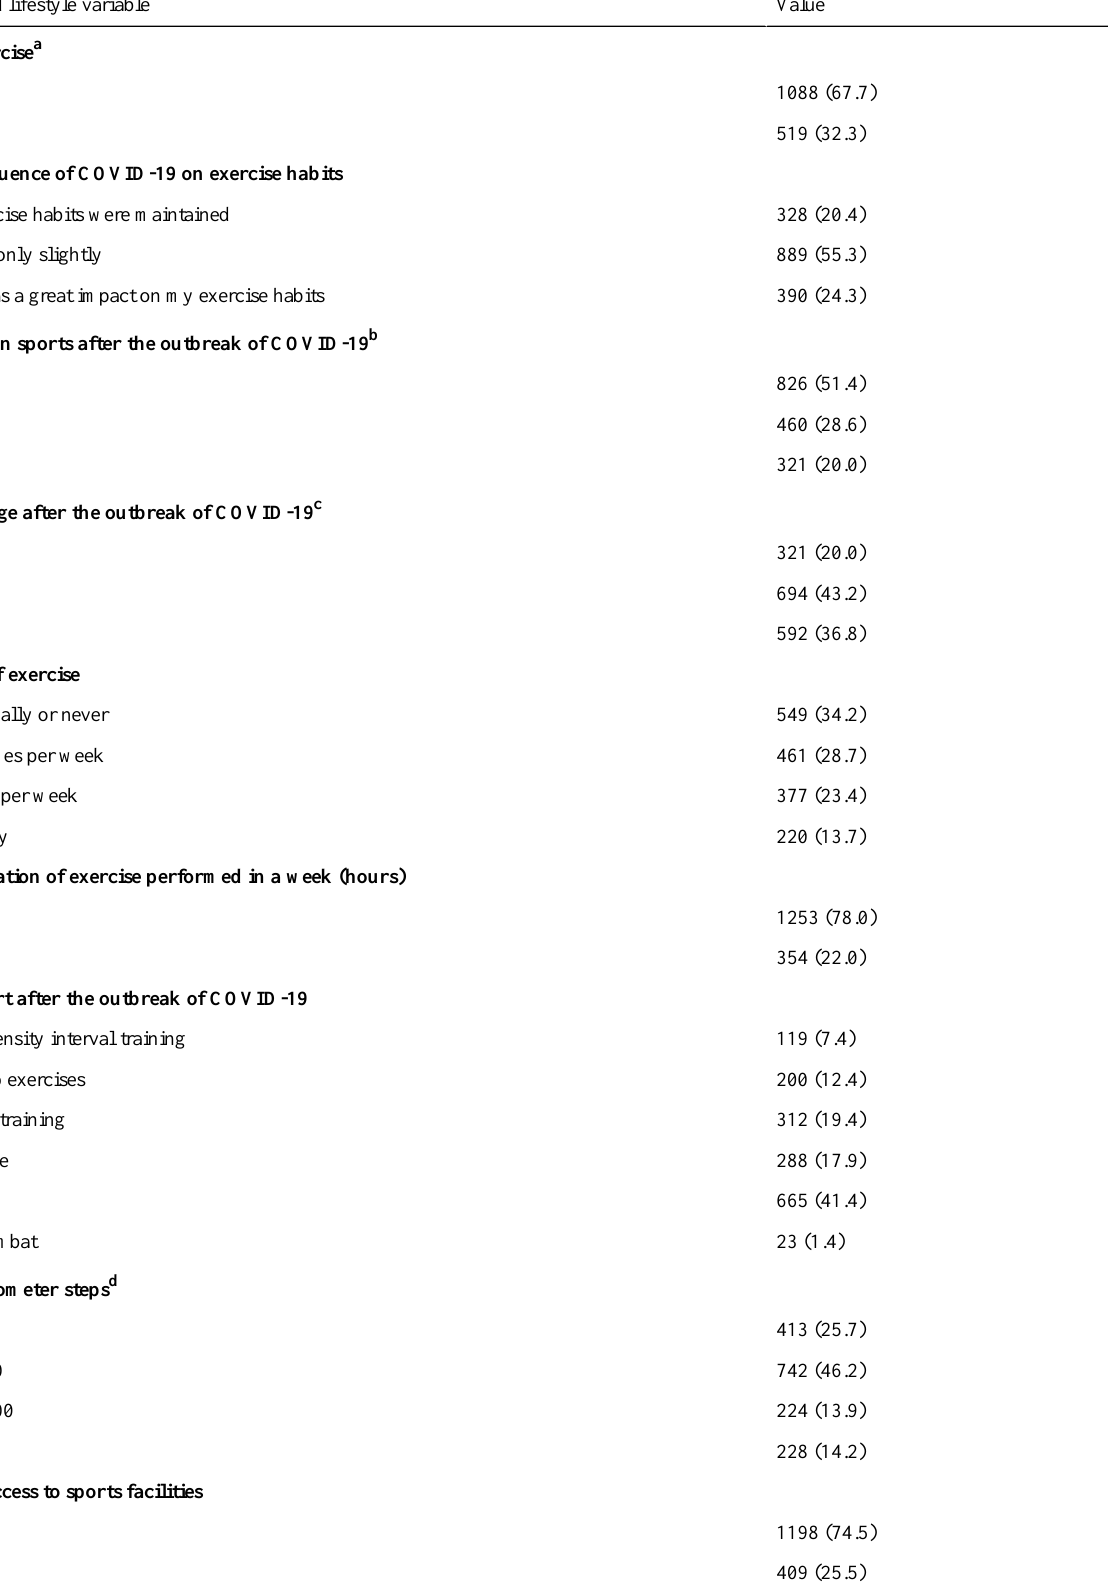
Table 3. Sports-related lifestyle variables of the survey respondents after the outbreak of COVID-19 (N=1607), n